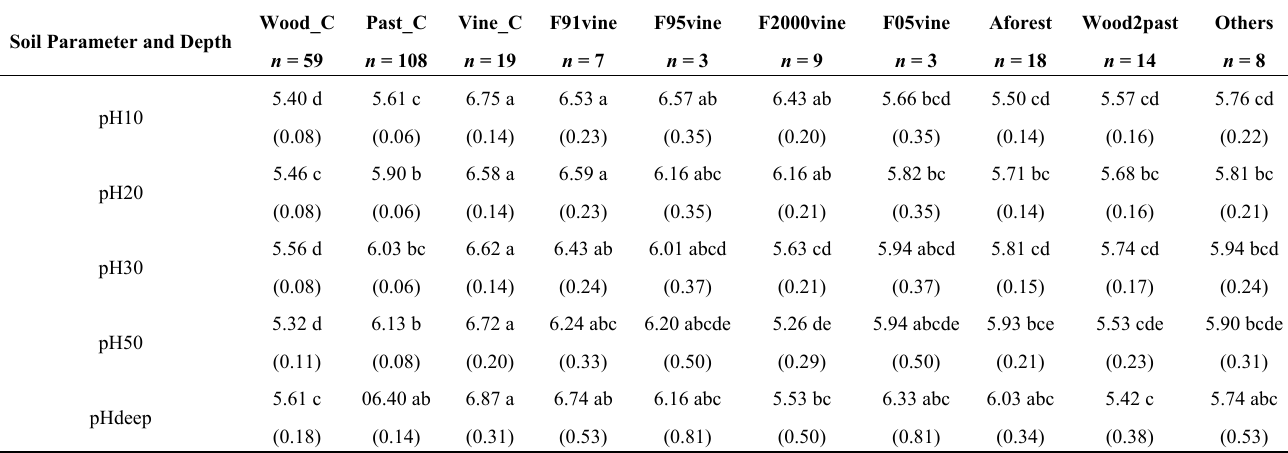
Table 2. Mean pH values of soils under different land use and land cover (LULC) categories; values in brackets are the standard